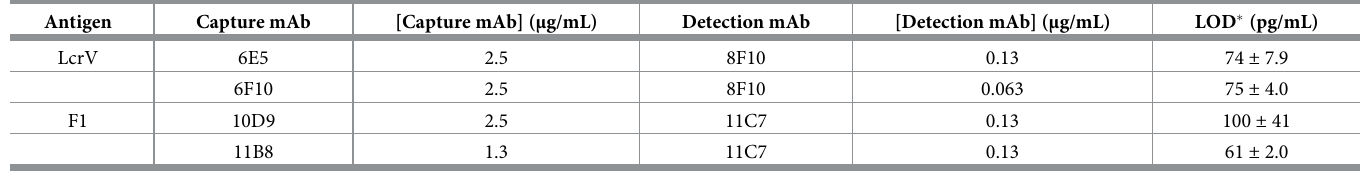
Table 4. Limit of detection of enzyme-linked immunosorbent assays using recombinant LcrV and F1 antigens in buffer. Antigen Capture mAb [Capture mAb] ( μ g/mL)